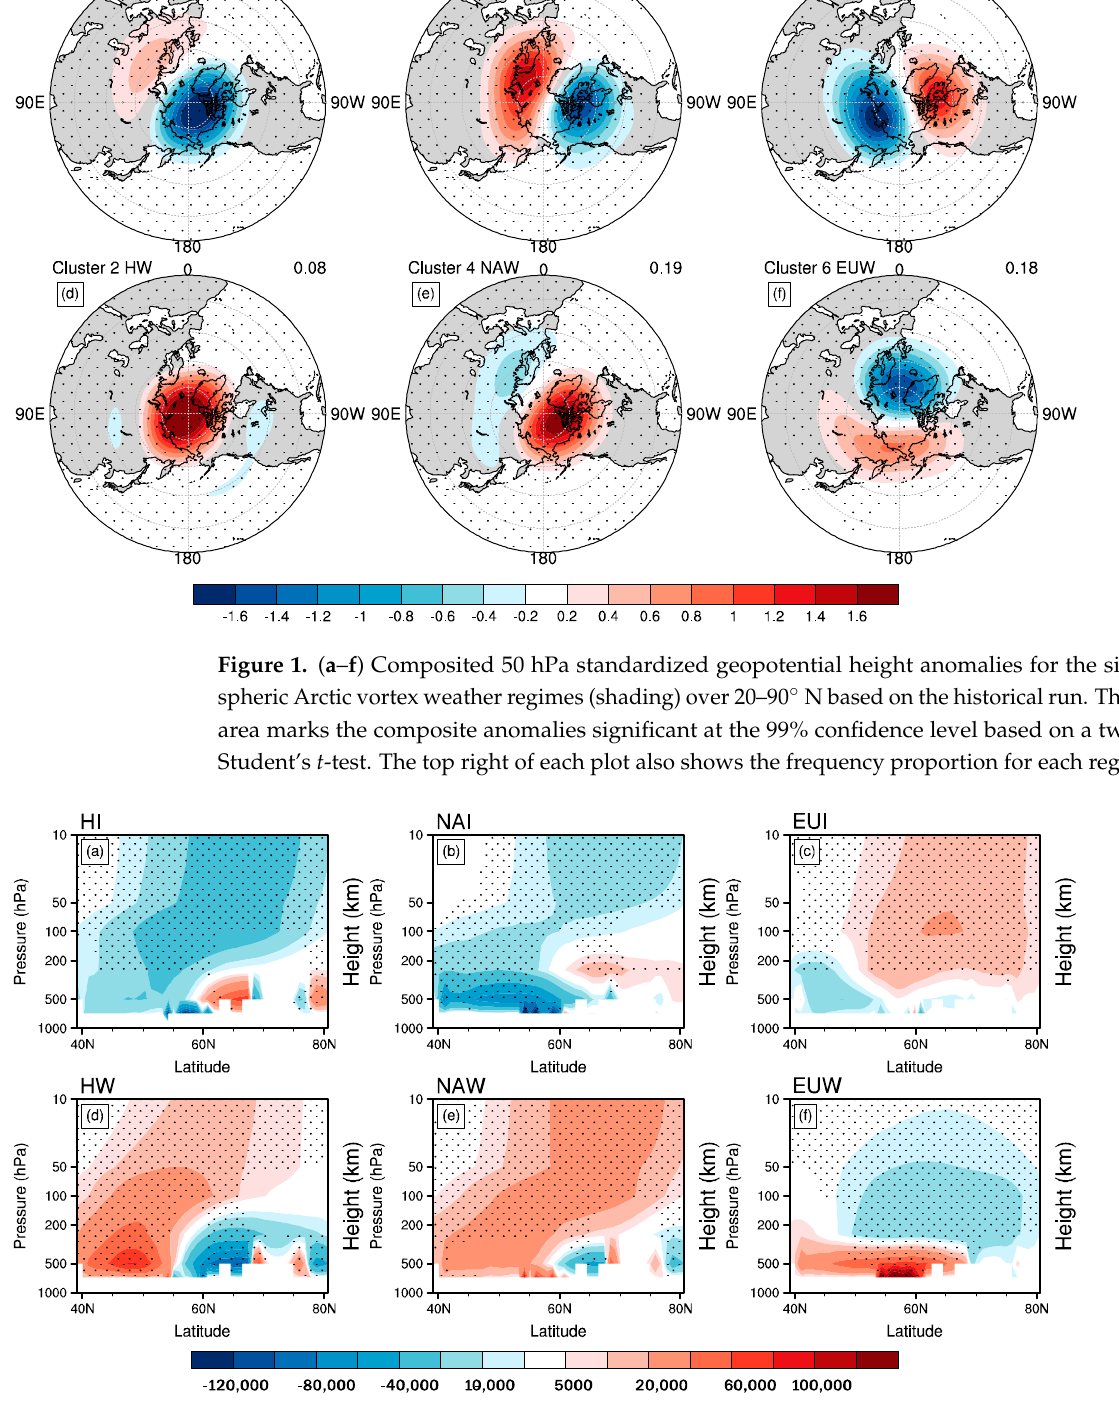
Figure 2. ( a – f ) Composited F z anomalies by total waves (units: Pa m 2 /s 2 ) for the six stratospheric Arctic vortex regimes from the historical runs. The dotted area manifests the composited eddy heat flux anomalies at the 99% confidence level based on a two-sided Student’s